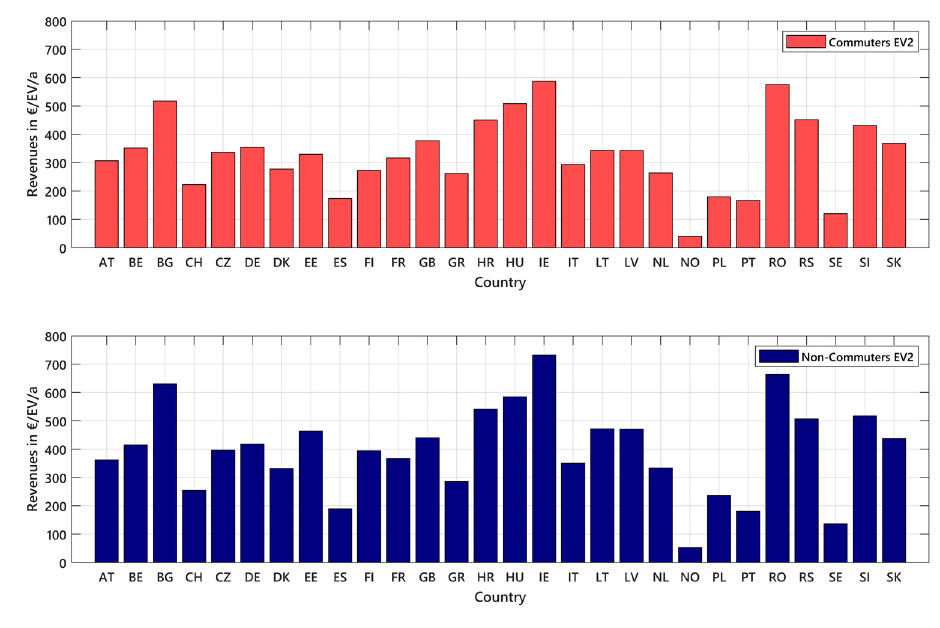
Figure 4. Revenues for bidirectionally chargeable EVs in di ff erent European day-ahead markets for market prices of 2019.